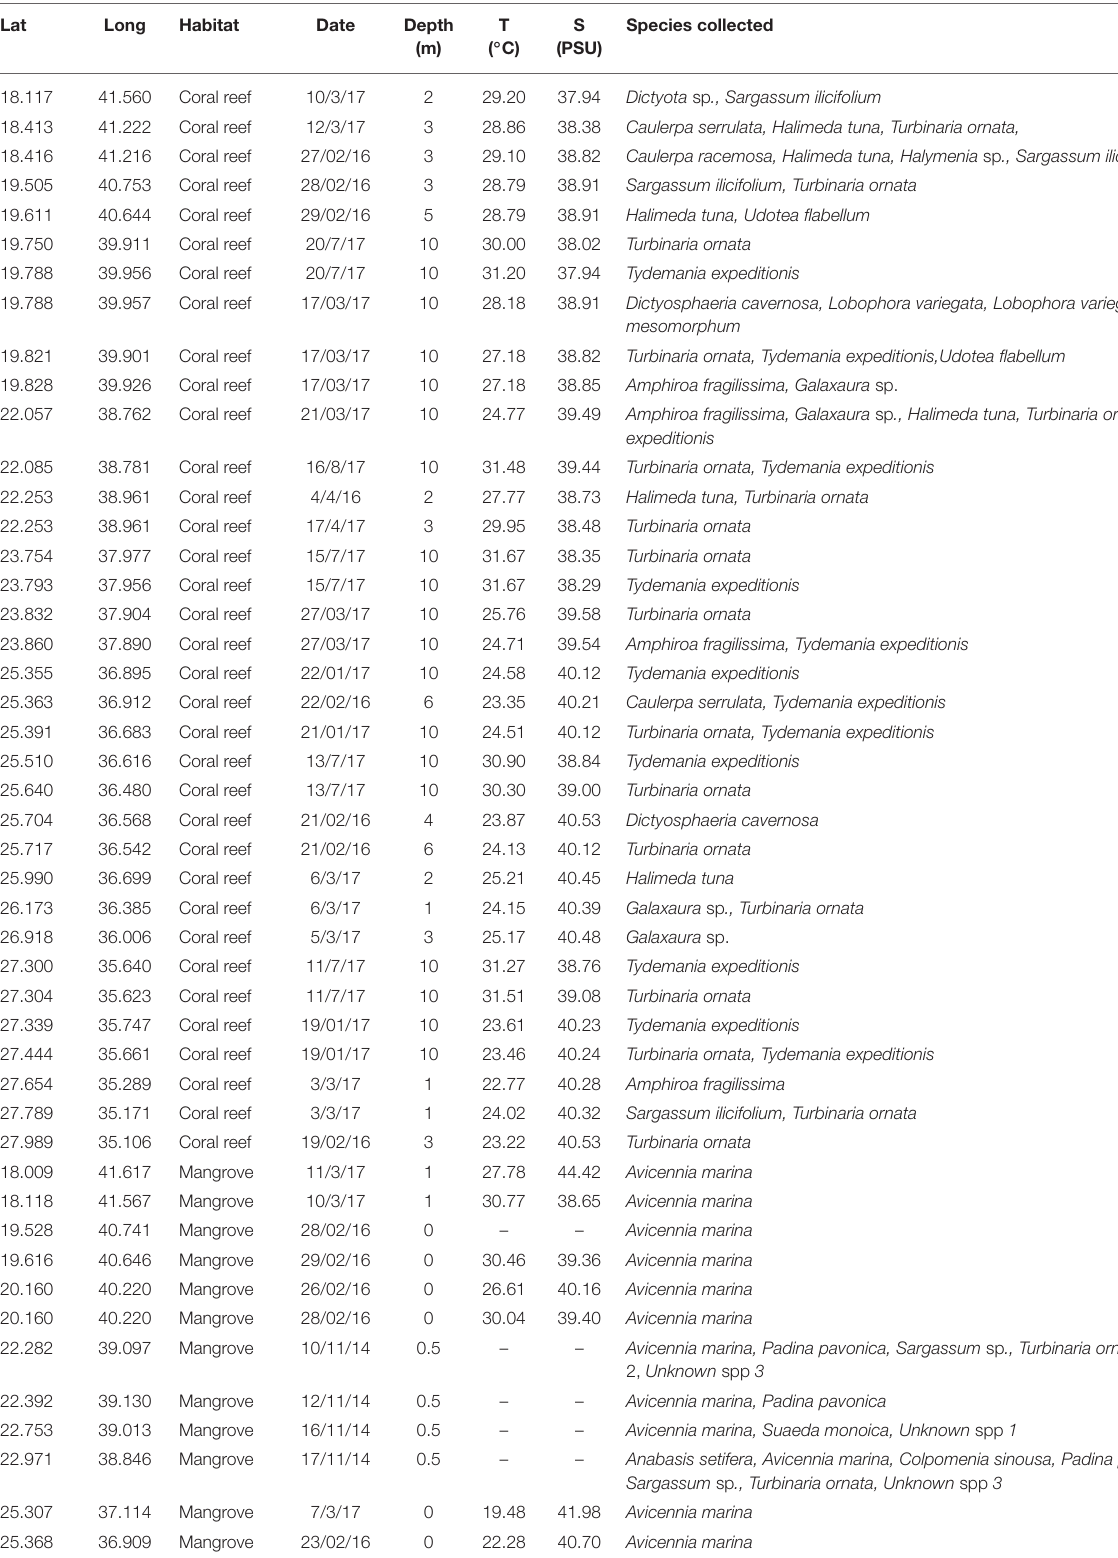
TABLE 1 | Summary with information of the 93 surveyed study sites in the Arabian Red Sea. Lat